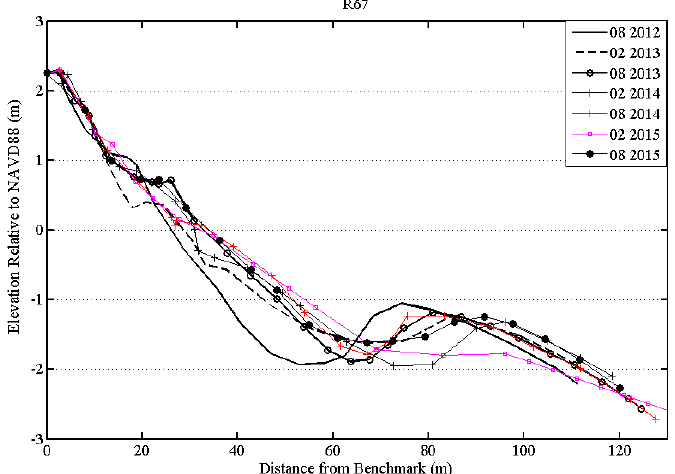
Figure 6. Example profile from the area of no fill along Belleair Shore between North Sand Key and Indian Rocks, at R67.